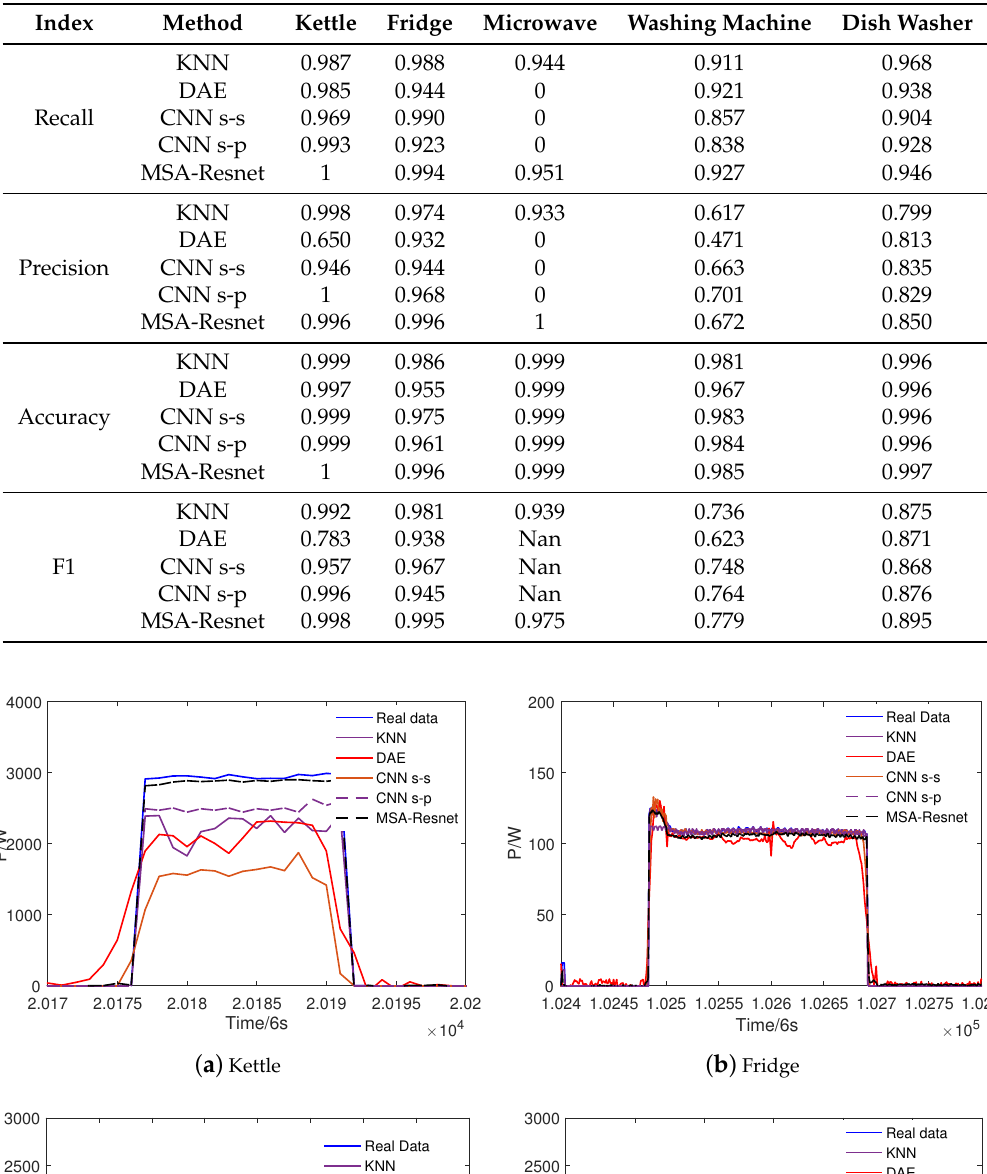
Table 5. Performance comparison of different algorithms for electrical on/off judgement of Household 5 in the UK-DALE dataset.